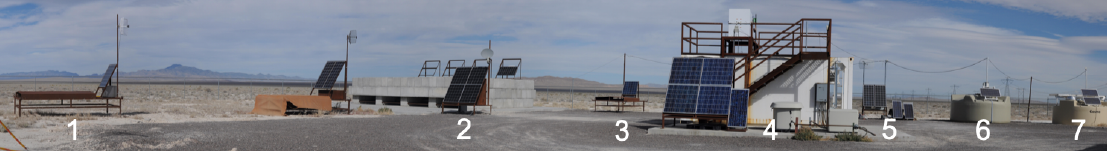
Figure 1. Auger@TA at the TA Central Laser Facility (CLF). 1: DET2421 (“global" TA). 2: LAN comm. and power system. 3: Local TA station. 4: CLF. 5: Auger@TA electronics and solar power system. 6: Auger north (AN) tank. 7: Auger south (AS) tank. The distance between DET2421 and the Auger doublet is about 45 m.